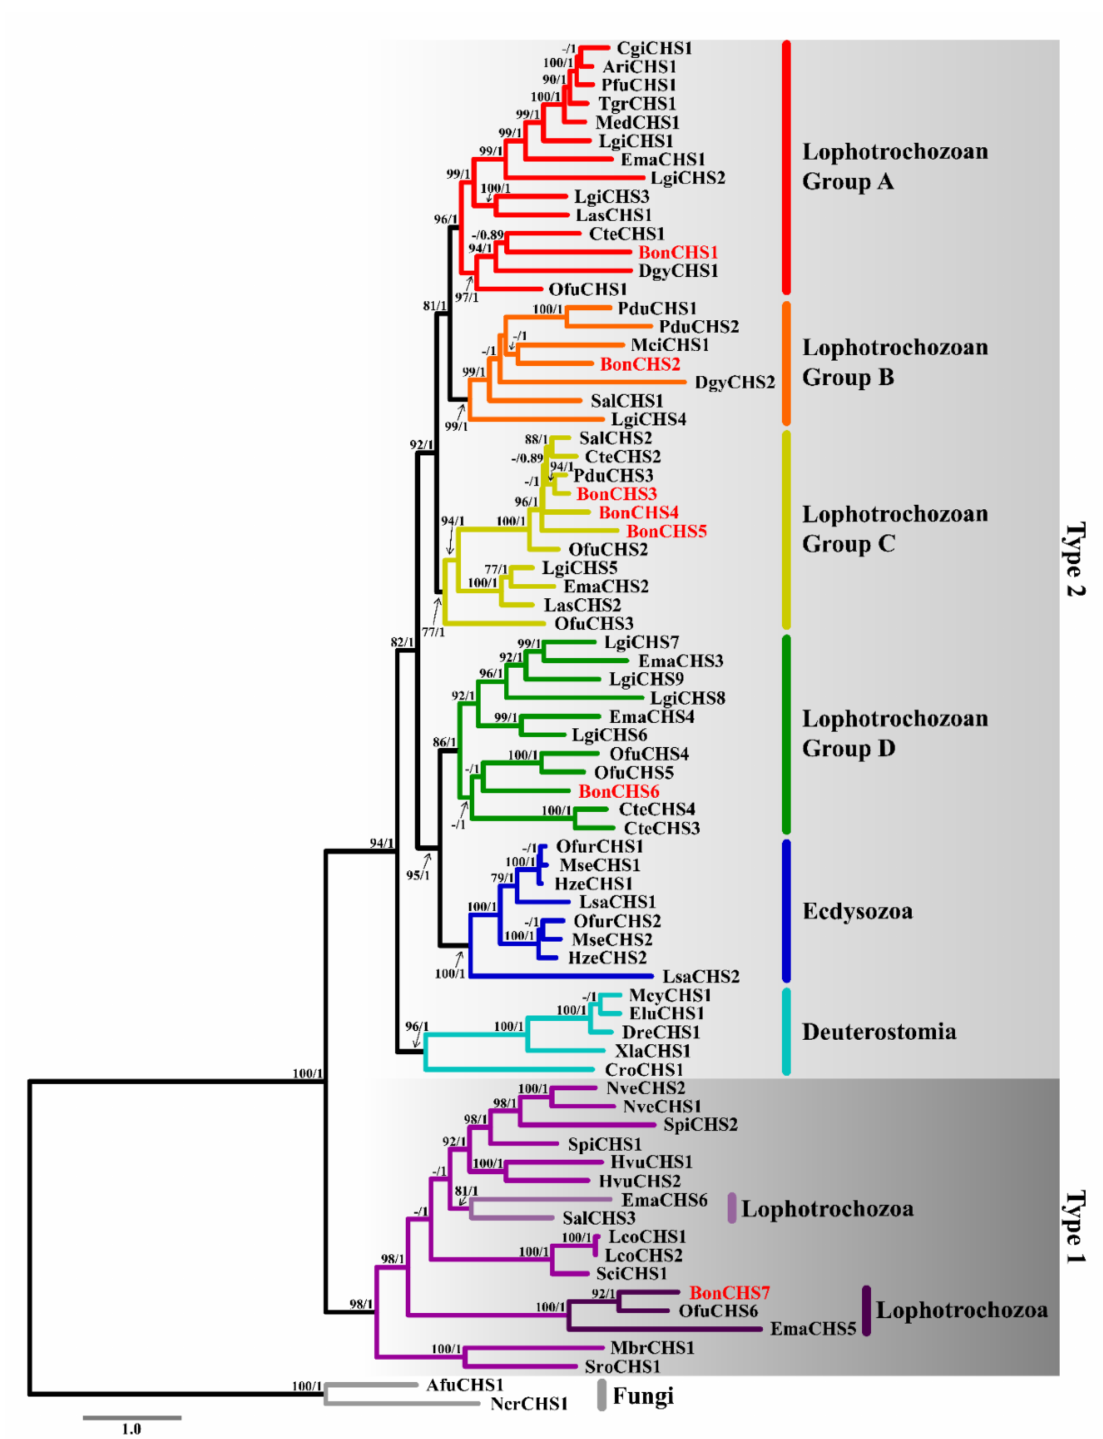
Figure 1. Maximum likelihood (ML) phylogeny of types 1 and 2 chitin synthase ( CHS ) genes: 74 amino acid sequences from 31 metazoans and two fungi. The fungi sequences were used as an outgroup. The gene names are abbreviated and listed in Table 1. CHS genes from Branchipolynoe onnuriensis are colored in red. Numbers in each node are supporting values and shown only > 70 and > 0.7 from the ML and Bayesian inference. The scale bar is provided at the bottom of the tree and represents the amino acid substitutions per